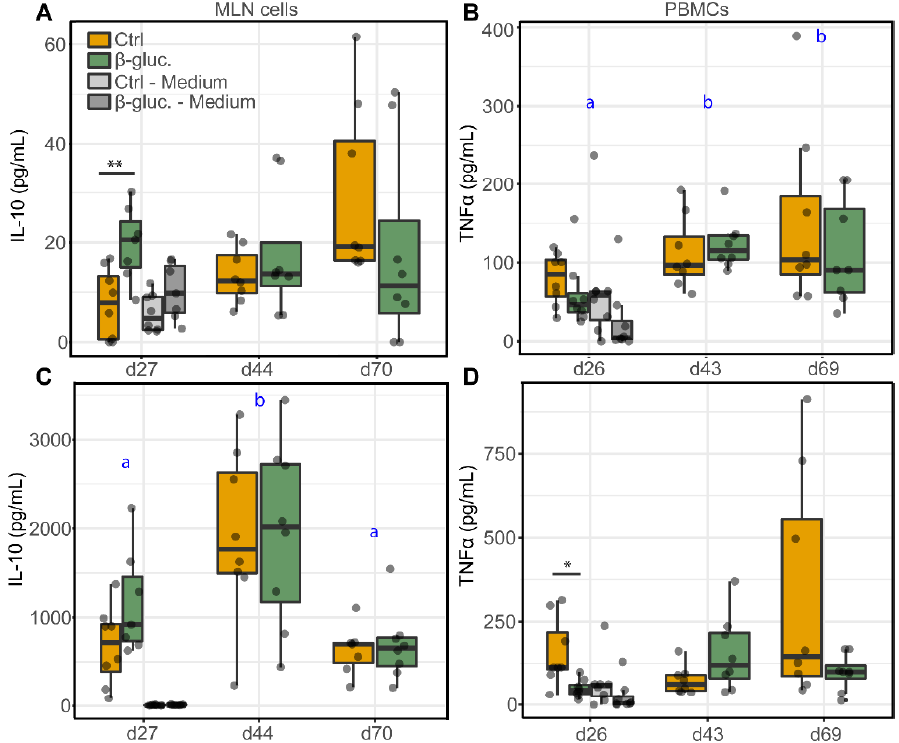
Figure 7. Levels of cytokines IL-10 ( A , C ) and TNF α ( B , D ) from stimulated MLN cells and PBMCs. MLN cells and PBMCs were stimulated with 10 µ g / mL LPS ( A , B ) or 5 µ g / mL Con-A ( C , D ), or left unstimulated (cell culture medium only) for 24 h. Significant di ff erences between the treatment groups are indicated by asterisks (**; p < 0.01 and *; p < 0.05). Letters (a, b) represent significant di ff erences ( p < 0.05) between time points. Every dot represents a single animal from a di ff erent pen ( n = 7 or 8 per treatment group) and error bars represent standard deviations. Statistical analysis was performed for every time point (T-test) and over time (Two-way ANOVA). Data were checked for normal distribution and equal variances and log-transformed when required.